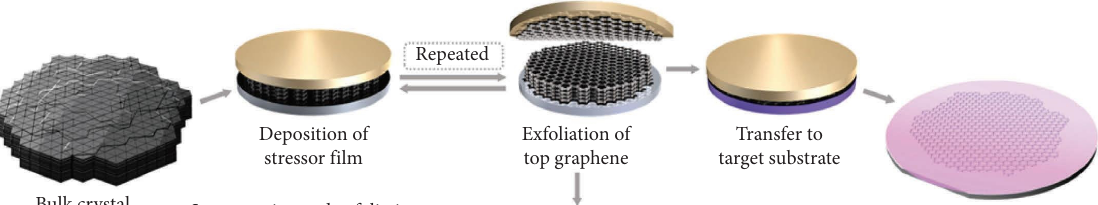
Figure 3: Layer-engineered exfoliation process [19].